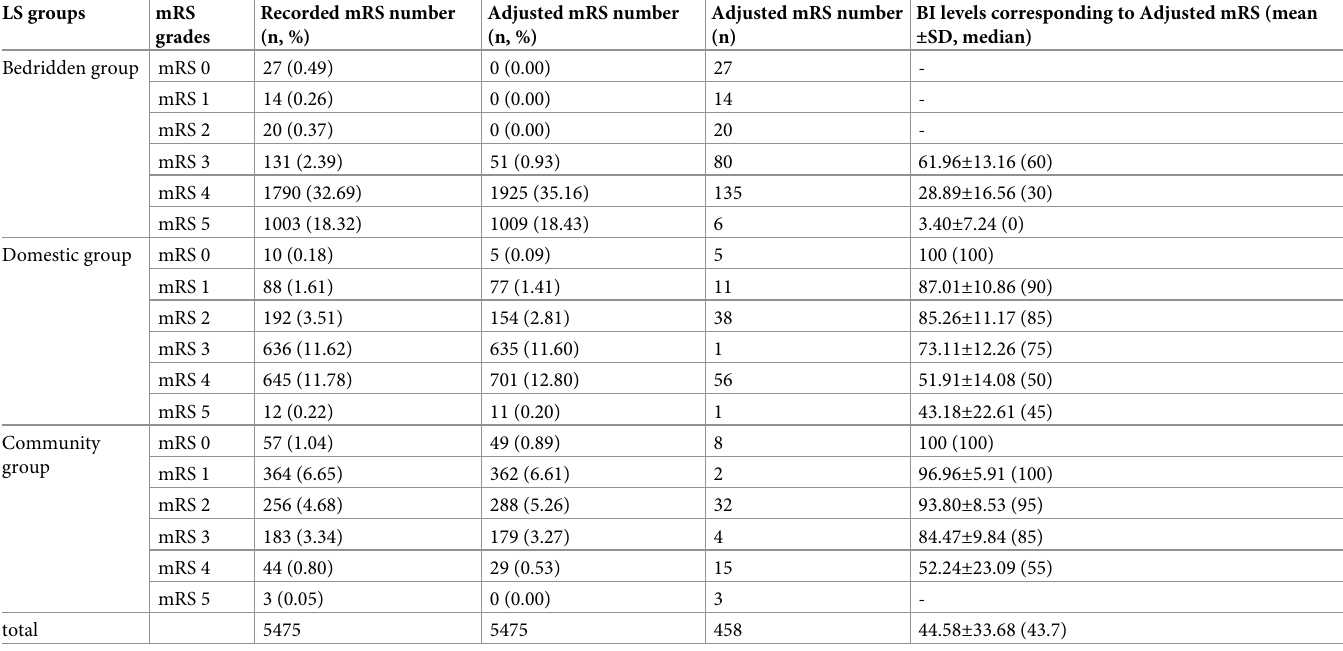
Table 2. The distribution of LS scale, recorded and adjusted mRS and